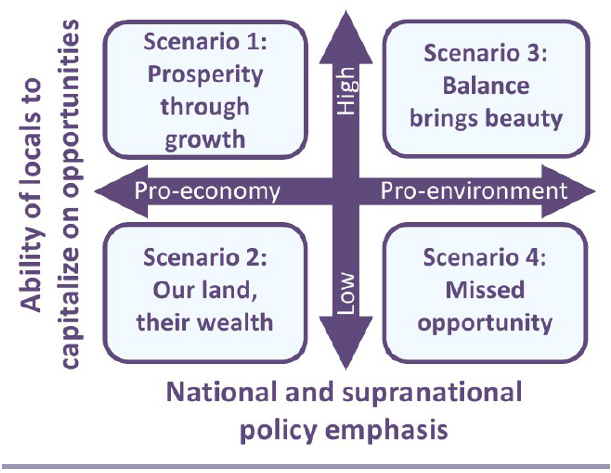
Fig. 7. Visual representations of key features of the four scenarios in terms of their effects on the landscape. Pro- economy settings lead to landscape simplification (scenarios 1 and 2), whereas pro-environment settings are likely to maintain landscape heterogeneity (including some land abandonment in scenario 4). Social and economic development for local villagers is particularly poor in scenario 2, and to a lesser extent in scenario 4; in both cases, villages are physically isolated from international farm